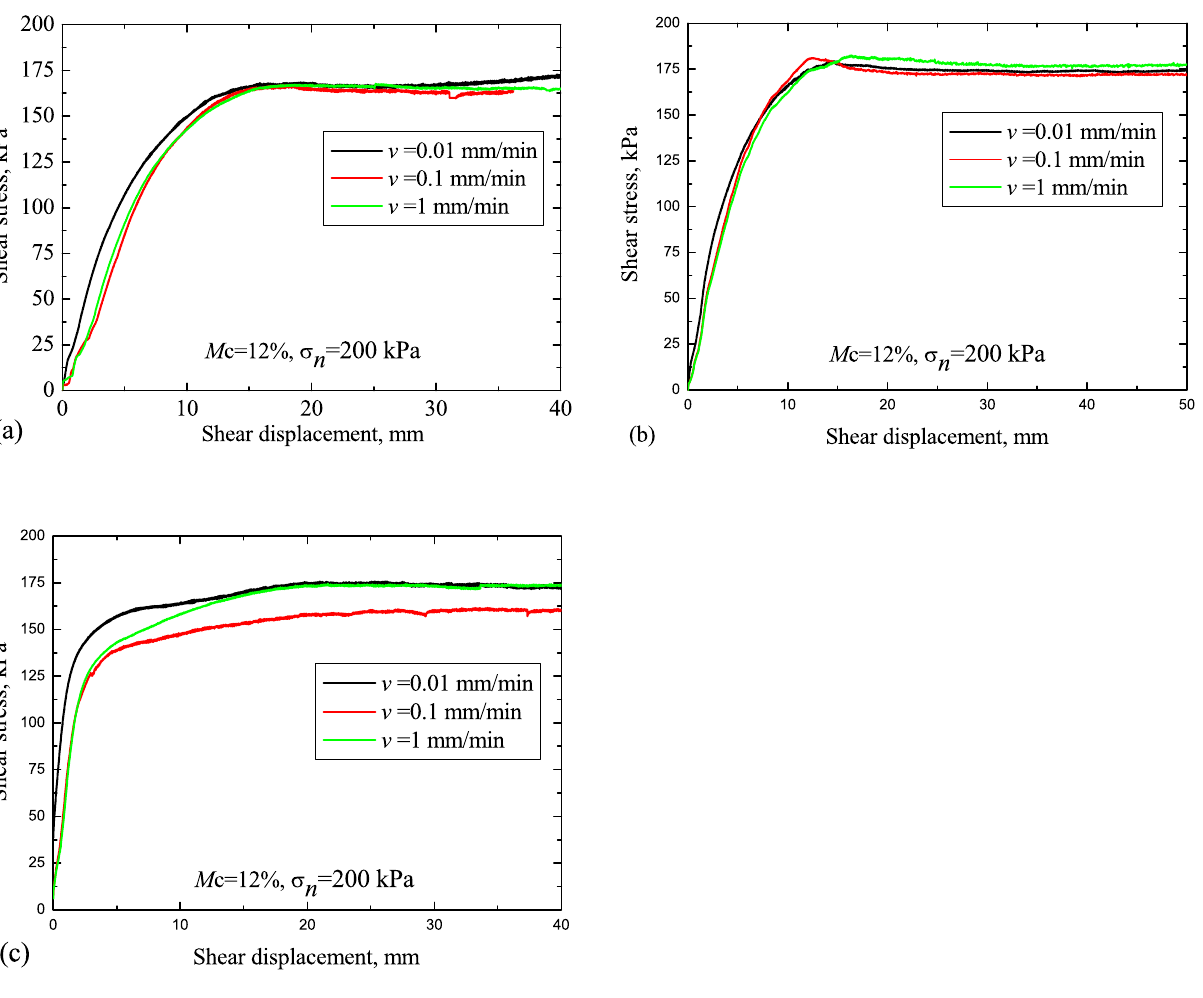
Figure 8. Shear stress versus shear displacement. ( a ) Loess; ( b ) red clay; ( c )